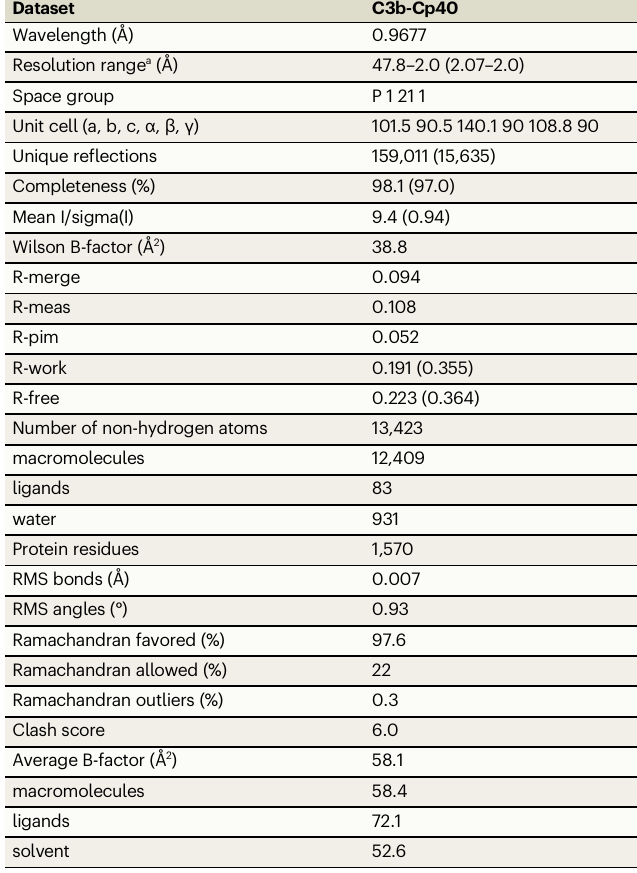
Table 2 | Crystallographic data, including experimental con- ditions, unit cell dimensions, data collection, and re fi